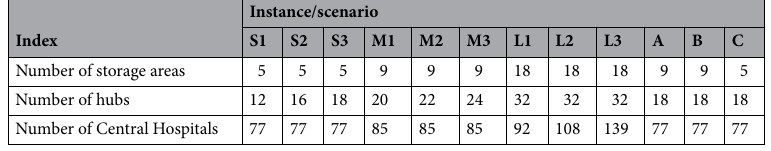
Table 6. Dataset containing nine random testing instances as well as three actual